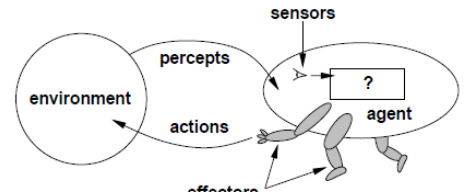
Figure 2. An intelligent agent – landscape scouts in our case - interacts with its